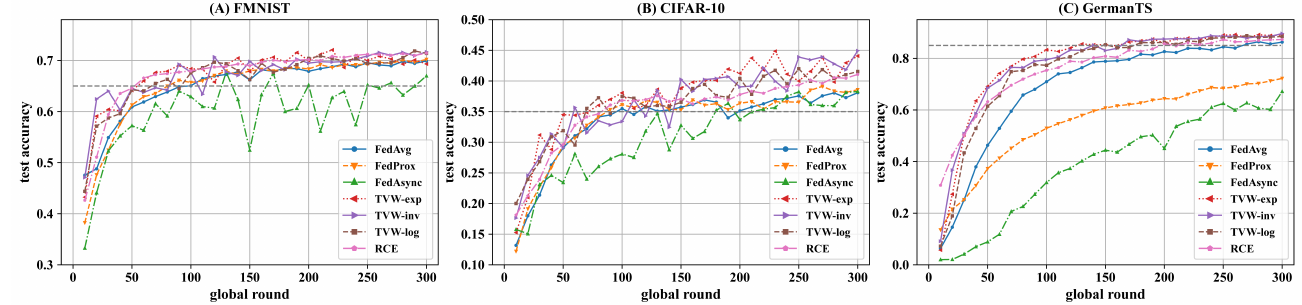
Figure 5. The accuracy curve of TVW and RCE compared with the baselines in ( A ) FMNIST; ( B ) CIFAR-10; and ( C ) GermanTS.